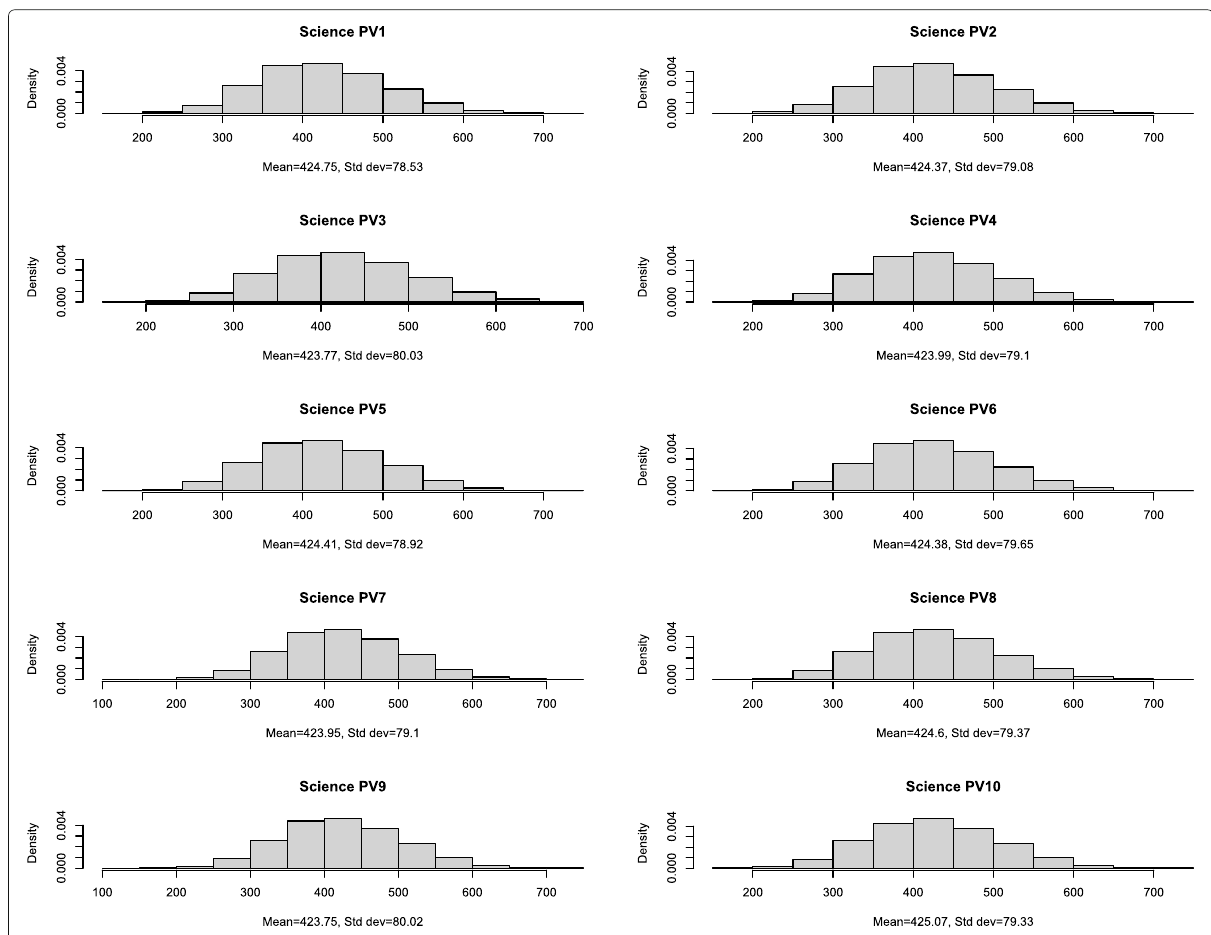
Fig. 3 Distribution of plausible values for the science performance of Colombian students in PISA